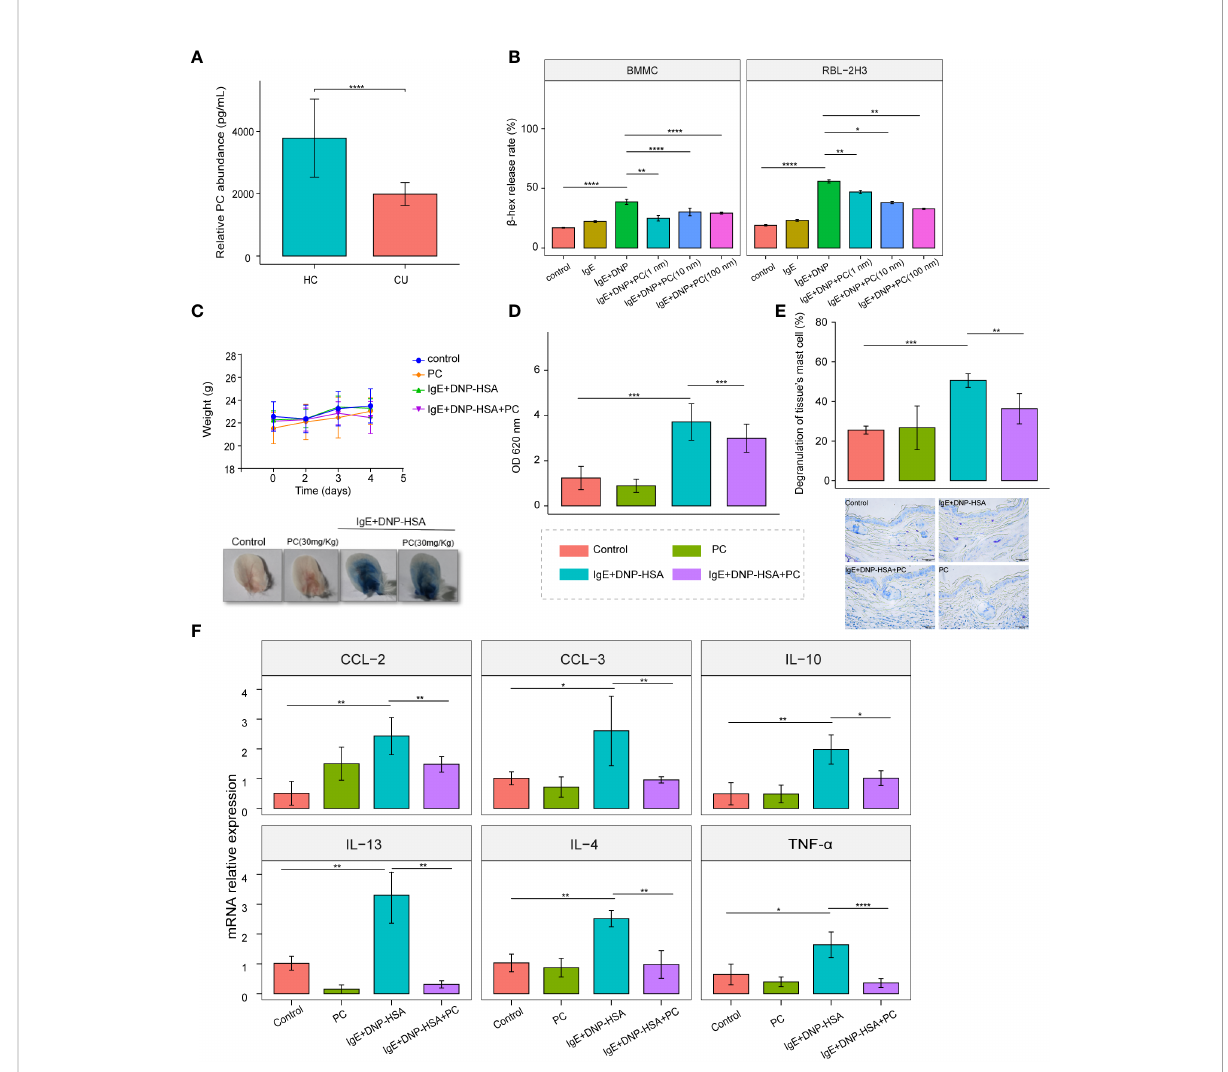
FIGURE 5 Supplementation with PC attenuates IgE-induced mast cell activation in vitro and in vivo . (A) The mean plasma PC level of the CU patients n = 42 was signi fi cantly lower than that of the HC subjects n = 42 were determined by ELISA. (B) PC (Including three concentrations: 1 nM,10 nM, and 100nM) inhibited the degranulation of RBL-2H3 cells and BMMCs, and there was no concentration dependence. (C) Bodyweight curve and phenotypic changes of four mice groups (Control, n = 5; PC, n = 5; IgE+DNP-HSA, n = 8; IgE+DNP-HSA+PC, n = 8) during the experiment. (D) PC intervention reduced skin vascular permeability in the PCA mice model. (E) Toluidine blue staining showed that PC inhibited degranulation of skin mast cells. (F) The expression of genes involved in cytokine was measured by real- time-qPCR analysis. PC inhibited cytokine release in PCA mice models, including IL-4, IL-10, IL-13, CCL-2, CCL-3, and TNF- a . The data from multiple experiments were expressed as the mean ± standard deviation (SD). Signi fi cant differences were evaluated using student t-test or the nonparametric test (Be denoted as follows: ****p ≤ .0001, ***p ≤ .001, **p ≤ .01, *p ≤